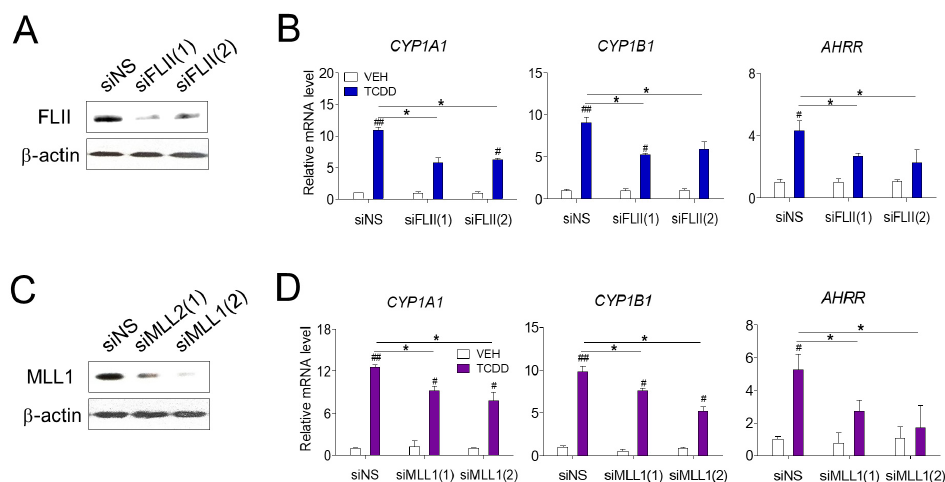
Figure 1. AHR-mediated transcription in ARPE-19 cells. ( A , B ) Reduction in the levels of endogenous FLII and MLL1 by siRNA. ARPE-19 cells were transiently transfected with siRNAs targeting two different sites of FLII mRNA (siFLII(1) or siFLII(2)), MLL1 (siMLL1(1) or siMLL1(2)), or non-specific siRNA (siNS) for 48 h. Endogenous FLII and MLL1 protein levels in ARPE-19 cells were measured by western blotting. ( C , D ) Reduction in the levels of endogenous FLII and MLL1 by siRNA attenuated the expression of AHR target genes. The expression of AHR target genes in ARPE-19 cells was analyzed by RT-qPCR. Cells were treated with 10 nM TCDD or vehicle (toluene). Data are presented as means ± S.D. (n = 3). * P < 0.05 vs. siNS, # P < 0.05 and ## P < 0.01 vs. vehicle control.